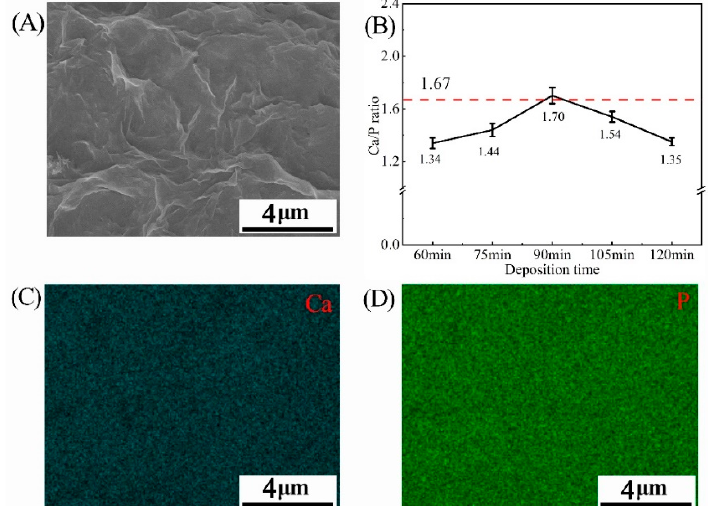
Figure 3. ( A ) SEM images of a dense and uniform surface of HA coating at deposition time of 90 min; ( B ) Ca/P ratio curve of HA coating on PVA/PLA braids at various deposition time; ( C , D ) EDS mapping analyses at 90 min.